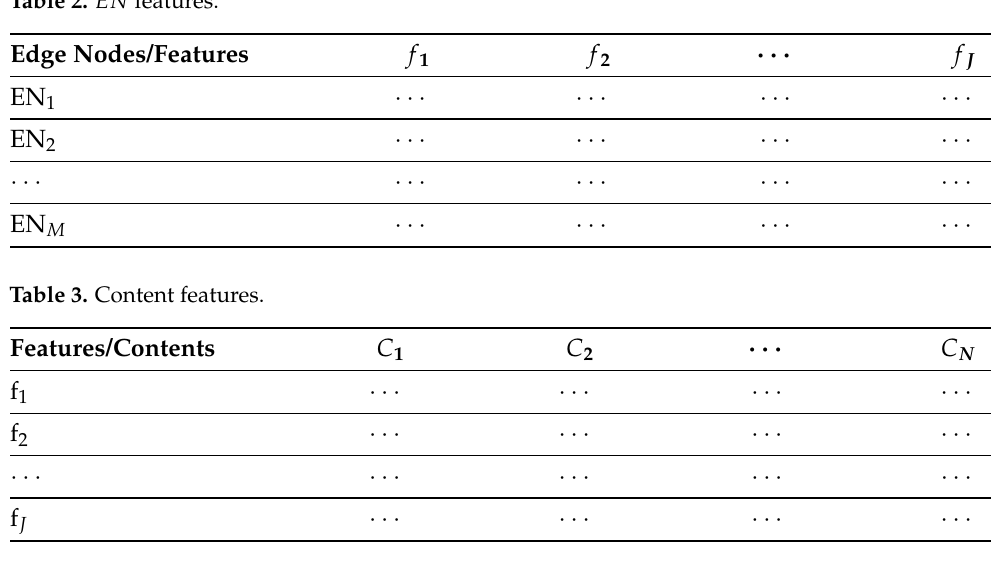
Figure 1. Three-tier network architecture. Table 2. EN features.